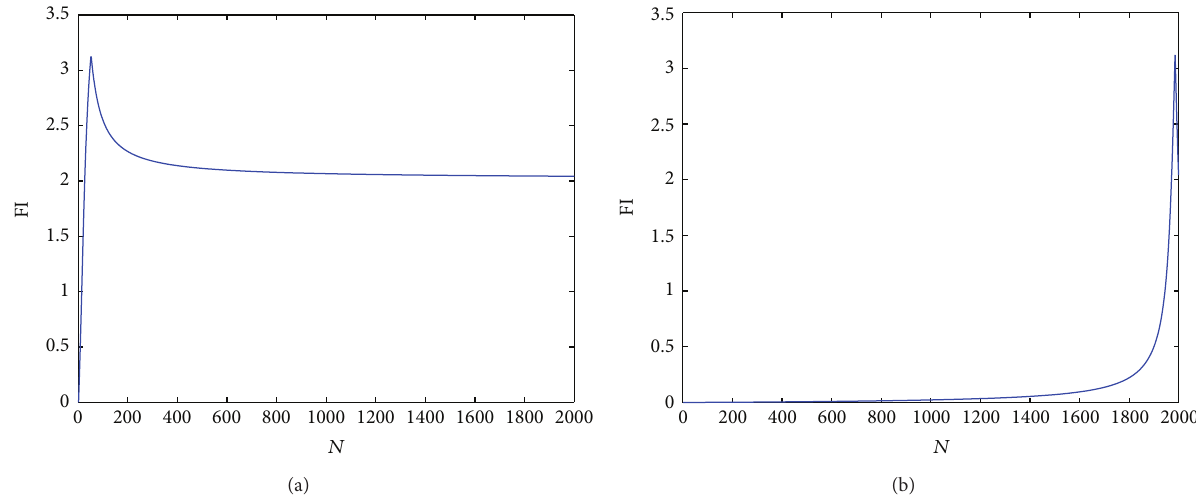
Figure 5: (a) The scanning of the component 𝑅3 from short circuit to open circuit, (b) FI about the scanning of the component 𝑅3 from open circuit to short